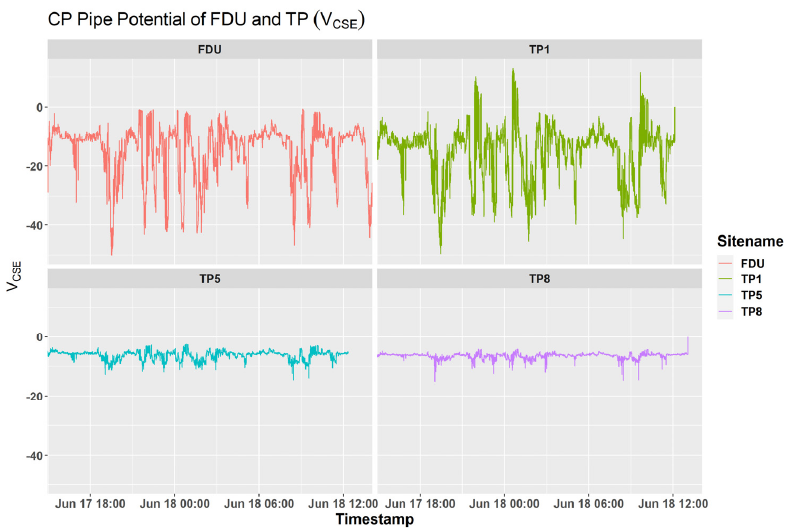
Figure 11. Downstream effect of stray current.